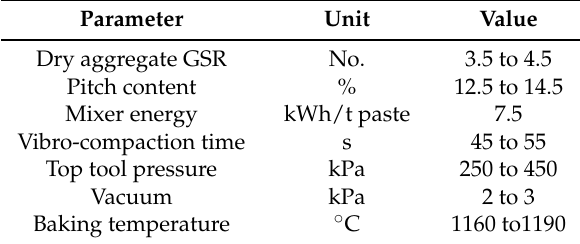
Table 3. Anode manufacturing parameters at the EMAL smelter.